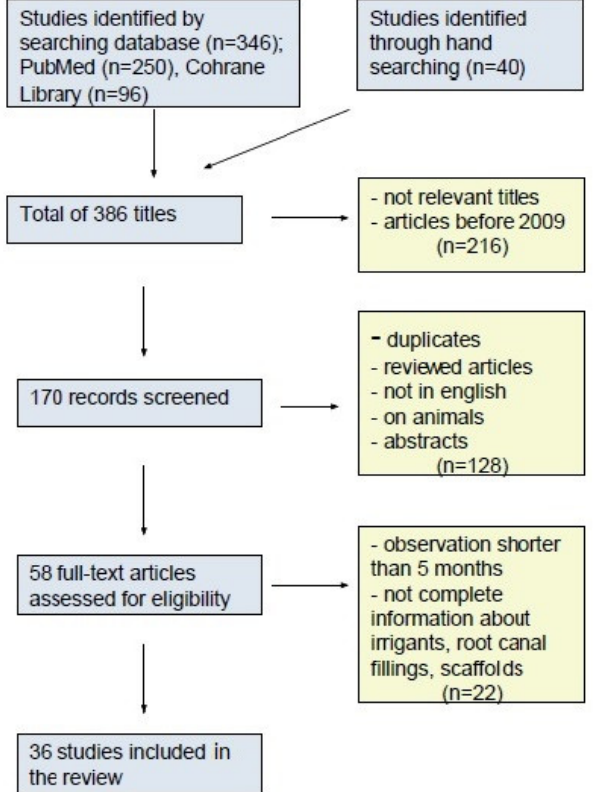
Figure 1. PRISMA (preferred reporting items for systematic reviews and meta-analysis) flow diagram of the article selection [54].